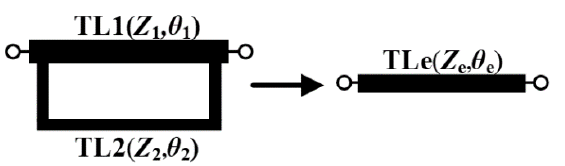
Figure 3. Equivalent structures of the STLS for different states.